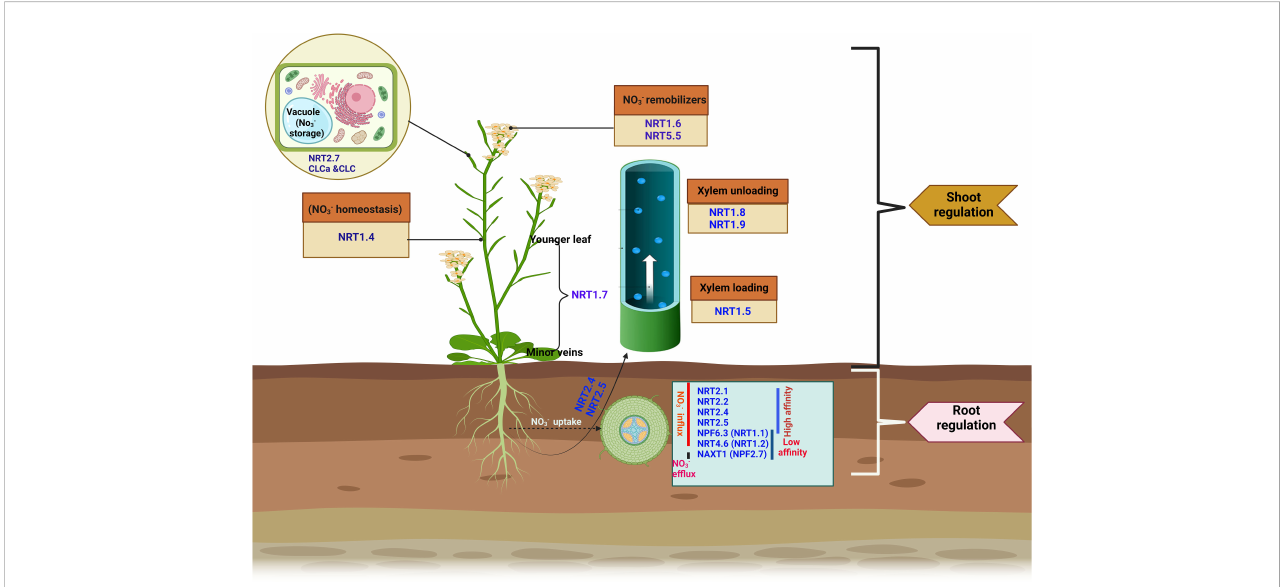
FIGURE 1 Key nitrate transporters involved in nitrate uptake, transport, and remobilization in plants. Nitrate transporters involved in NO 3 (cid:1) acquisition from the root include NRT2.1 , NRT2.2 , NPF4.6 ( NRT1.2 ), NRT2.4 , NRT2.5 , and NPF6.3 ( NRT1.1 ). NPF2.7 performs the NO 3 (cid:1) ef fl ux function. In addition to the uptake function, NRT2.4 and NRT2.5 facilitates root-to-shoot NO 3 (cid:1) transport. NRT1.5 is responsible for xylem loading, while NRT1.8 and NRT1.9 functions to unload NO 3 (cid:1) from the xylem. NRT1.4 regulates NO 3 (cid:1) homeostasis, and the expression of NRT1.7 in the phloem of the minor vein promotes nitrate remobilization from mature to younger leaves. At shoot, NRT1.6 and NPF5.5 act as a NO 3 (cid:1) remobilizer, remobilizing NO 3 (cid:1) in the embryo. NRT2.7 enhances NO 3 (cid:1) storage in the seed